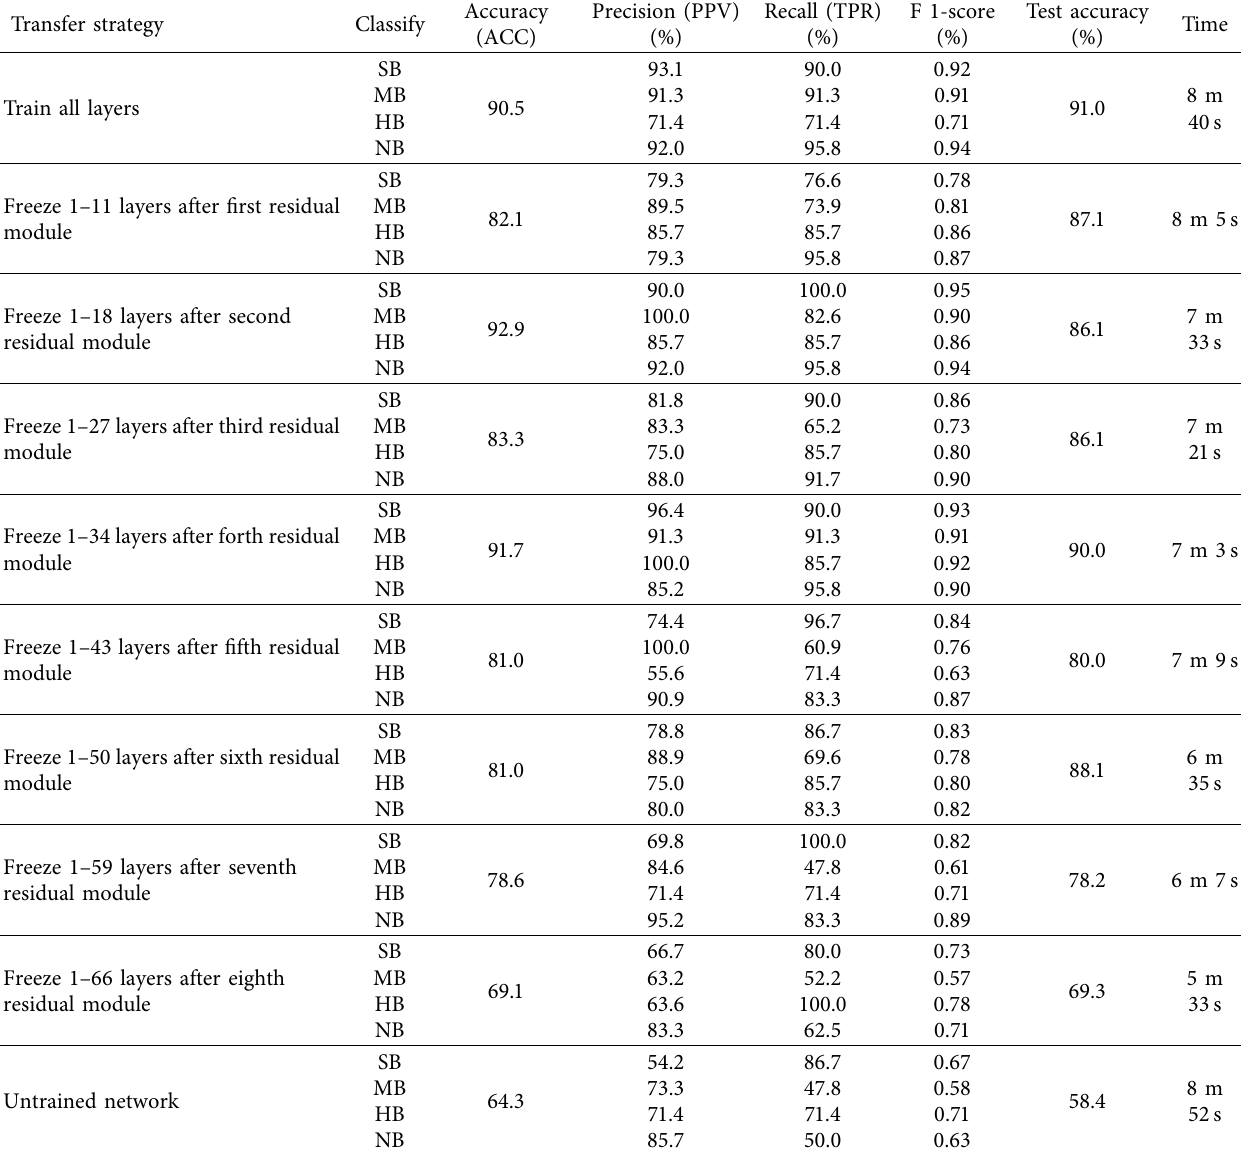
Table 4: ResNet-18 different transfer policy comparison.